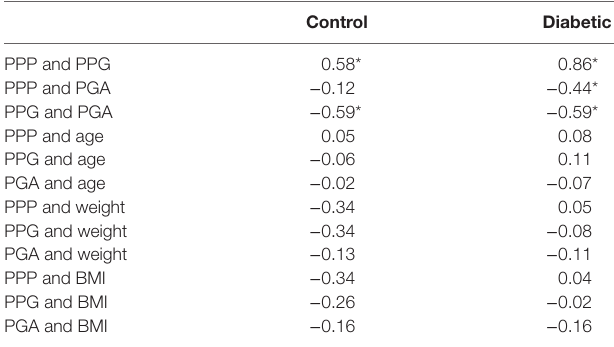
TaBle 1 | correlations among variables in the control and diabetic